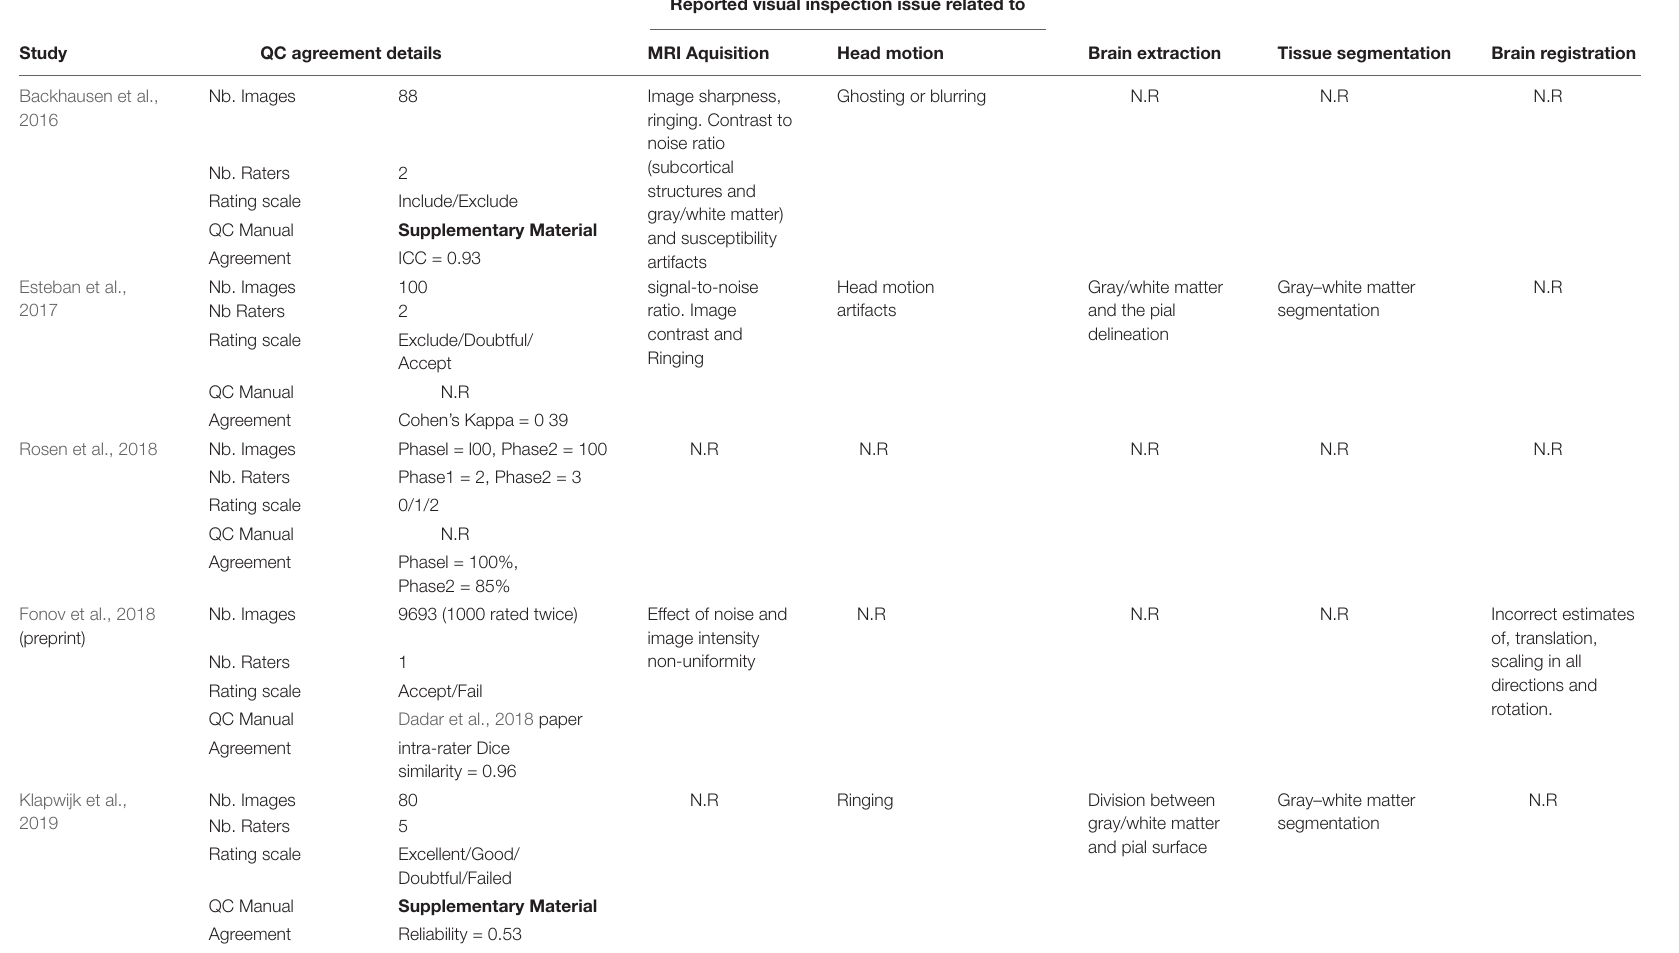
TABLE 1 | Reported agreement in visual inspection of sMRI data on QC